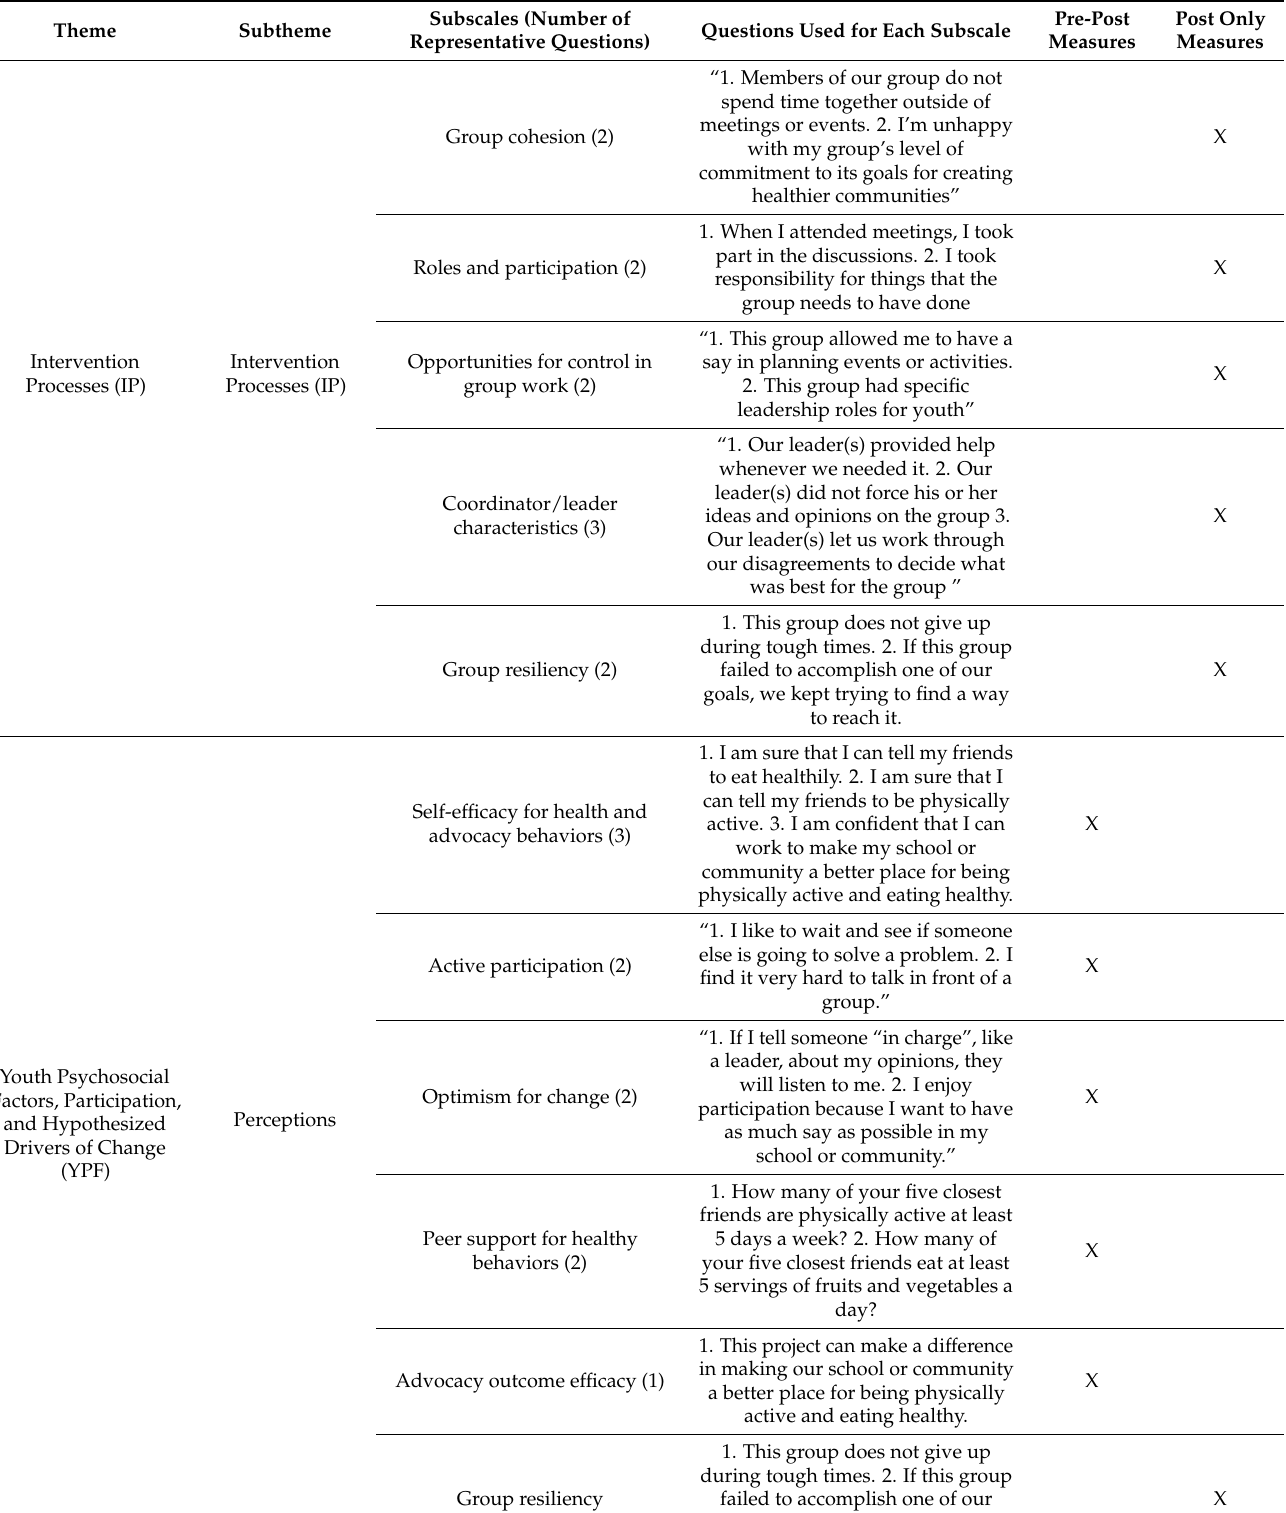
Table A2. Survey questions for each